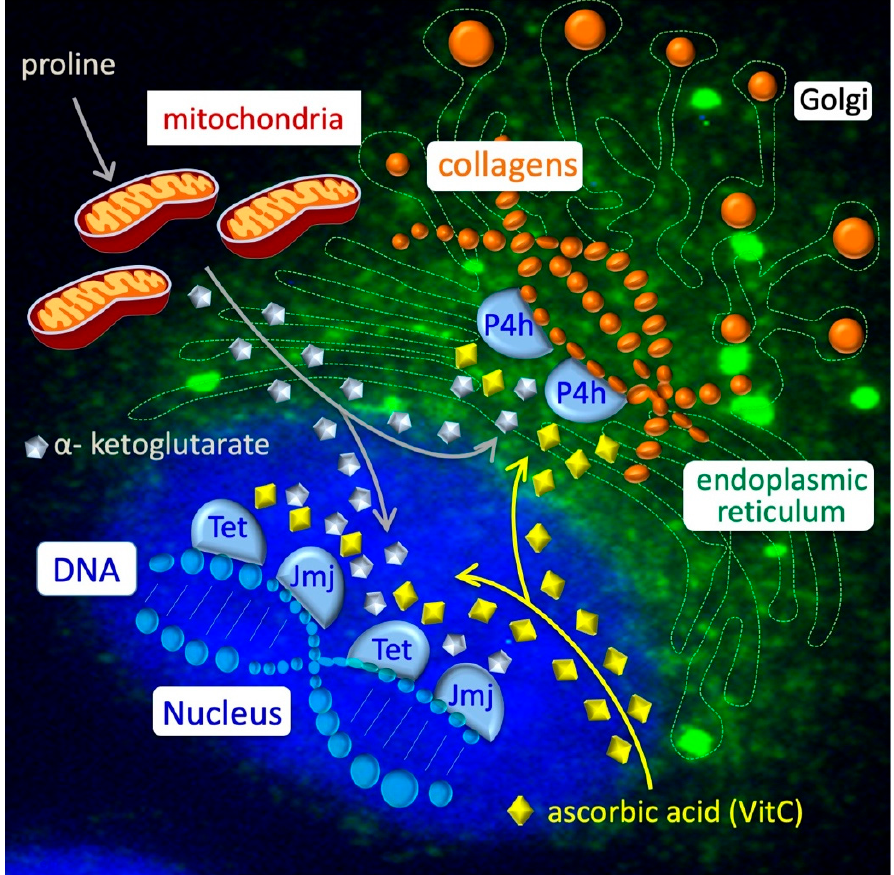
Figure 3. Collagen–epigenetic metabolic interplay in ESC-to-PiC transition. Intracellular proline is transported inside the mitochondria (grey line) and converted into α -ketoglutarate or used to load free prolyl-tRNA, which is essential for the synthesis of proline-rich proteins as collagens. Nascent collagens (orange balls) are hydroxylated in proline residues by Prolyl 4-hydroxylase (P4h) enzymes in the endoplasmic reticulum (green) and secreted through Golgi vesicles into the extracellular space. In the nucleus (blue), Tet and Jmj enzymes catalyze hydroxylation (demethylation) of DNA and histones. Reduced ascorbic acid/vitamin C (yellow diamonds) is essential for the activity of a large family of dioxygenases, including P4h, Tet and Jmj enzymes.